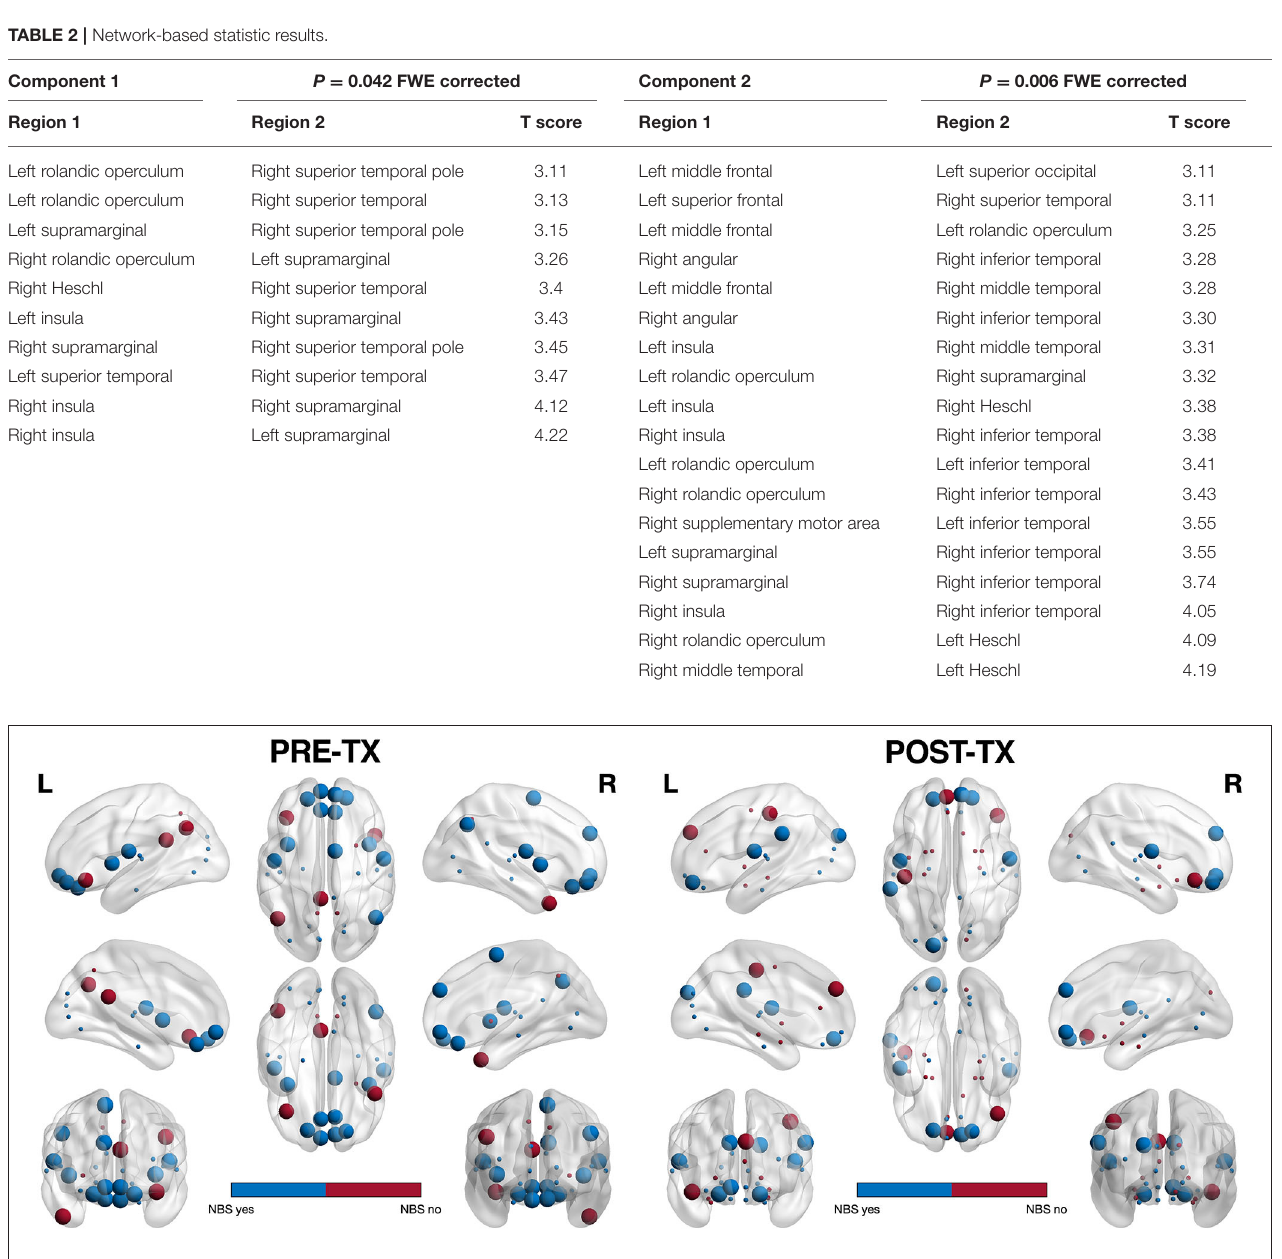
FIGURE 2 | Hub profile visualization. Of the regions connected by NBS significant edges (shown in blue), 78% were classified as hubs. In the PRE-TX group, 52% of hub regions were connector (larger spheres) vs. provincial (smaller spheres) whereas in the POST-TX group, 70% were provincial. This difference was significant ( z = 1.85, p =